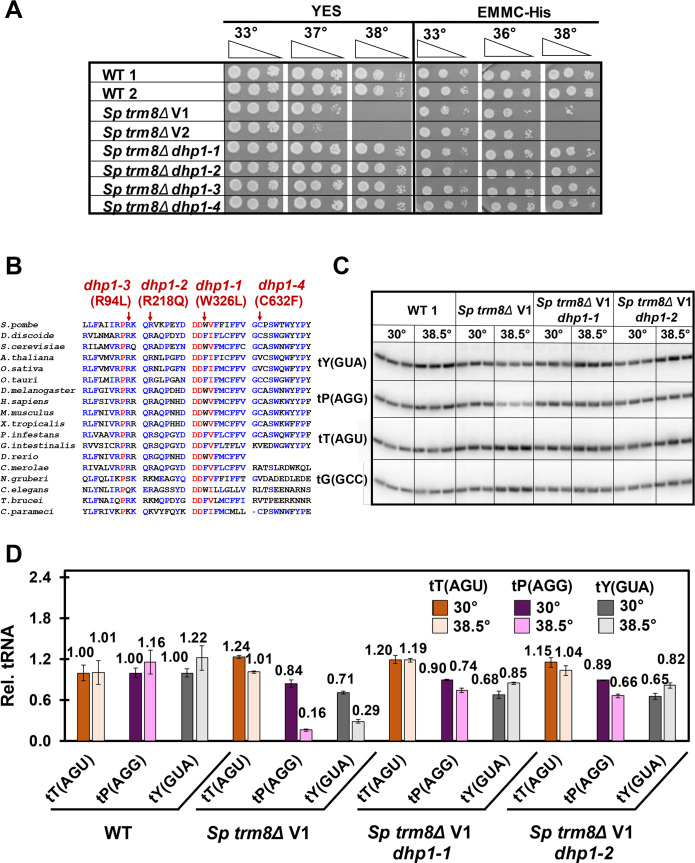
Mutations in dhp1 suppress the temperature sensitivity of S. pombe trm8Δ mutants and restore tP(AGG) and tY(GUA) levels.(A) dhp1 mutations restored growth of trm8Δ mutants at high temperature. Strains as indicated were grown overnight in YES media at 30°C and analyzed for growth as in Fig 1B. (B) Mutations in dhp1 that restored growth of S. pombe trm8Δ mutants reside in evolutionarily conserved residues. The amino acid sequence of Sp Dhp1 was aligned with putative Rat1/Dhp1 orthologs from 17 evolutionarily distant eukaryotes, using MultAlin (http://multalin.toulouse.inra.fr/multalin/) [135]. red, > 90% conservation; blue, 50%-90% conservation. Alleles of dhp1 mutations are indicated at the top. (C) Each of two trm8Δ dhp1 mutants had restored tRNA levels in YES media at 38.5°C. Strains were grown in YES media at 30°C and shifted to 38.5°C for 8 hours, and RNA was isolated and analyzed by northern blotting as in Fig 2A. (D) Quantification of tRNA levels of trm8Δ dhp1 mutants shown in Fig 3C. tRNA levels were quantified as in Fig 2B. tT(AGU), brown; tP(AGG), purple; tY(GUA), gray; dark shades, 30°C; light shades, 38.5°C.